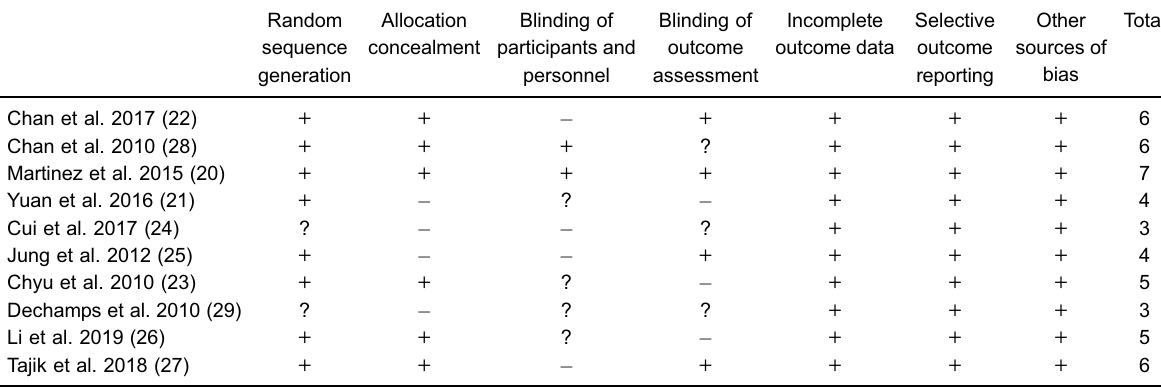
Table 1. Risk of bias assessment of included randomized clinical